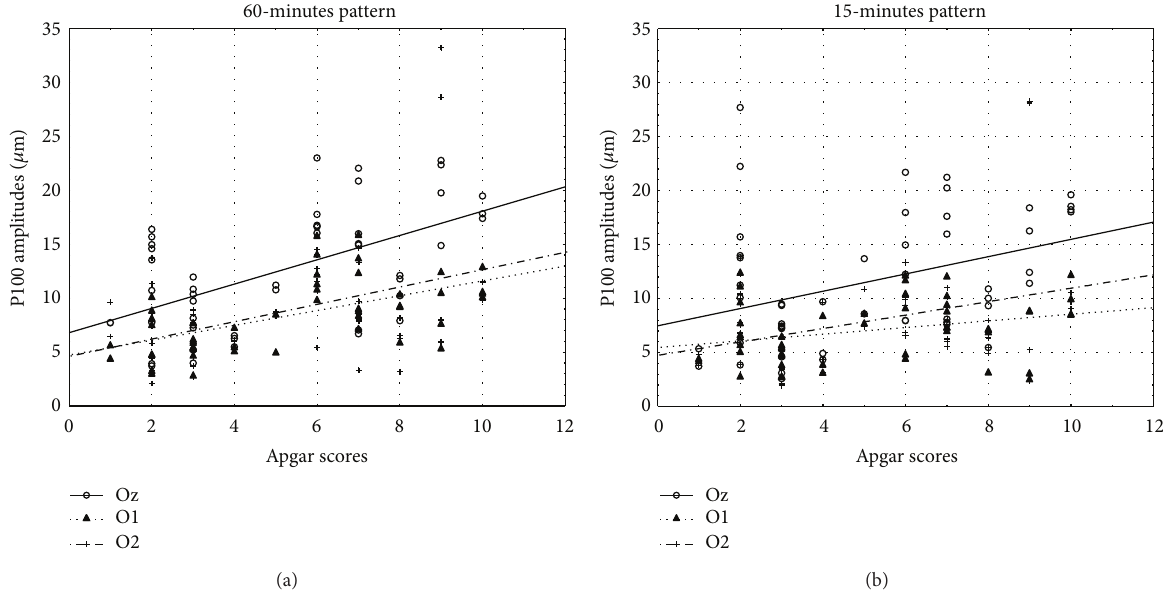
Figure 6: Scatter diagram showing a positive linear correlation between P100 amplitudes ( 𝜇 m) and amount of Apgar score in 15- and 60- minute pattern